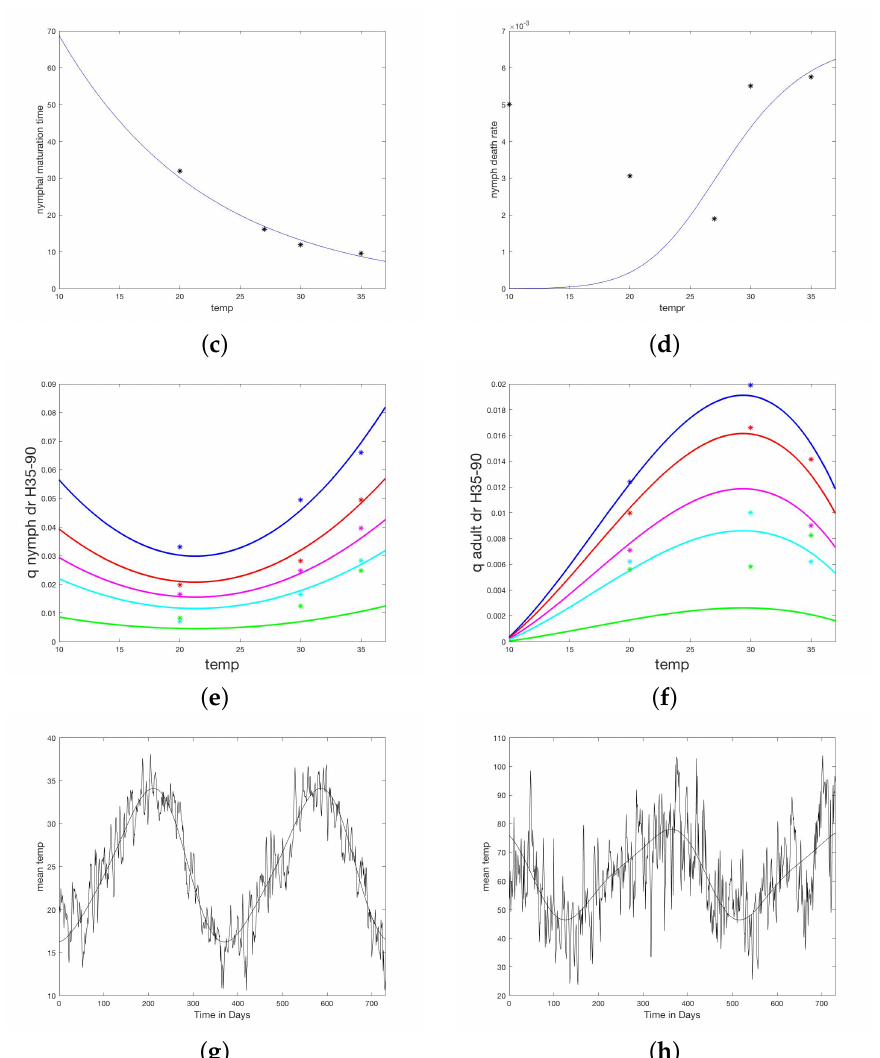
Figure 2. Temperature and humidity dependent responses of maturation and death times or rates fit to data from Koch and Tuck [20]. ( a ) Larvae maturation times as a function of temperature. ( b ) Larvae death rate as a function of temperature. ( c ) Nymph maturation times as a function of temperature. ( d ) Nymph death rate as a function of temperature. ( e ) Unfed (questing) nymph death rate as a function of both temperature and humidity. Each curve represents a humidity level from bottom (90) to top (35%). ( f ) Unfed (questing) adult death rate as a function of both temperature and humidity. Each curve represents a humidity level from bottom (90%) to top (35%). ( g ) Fourier approximation to temperature data for the study site. ( h ) Fourier approximation to humidity data for the study